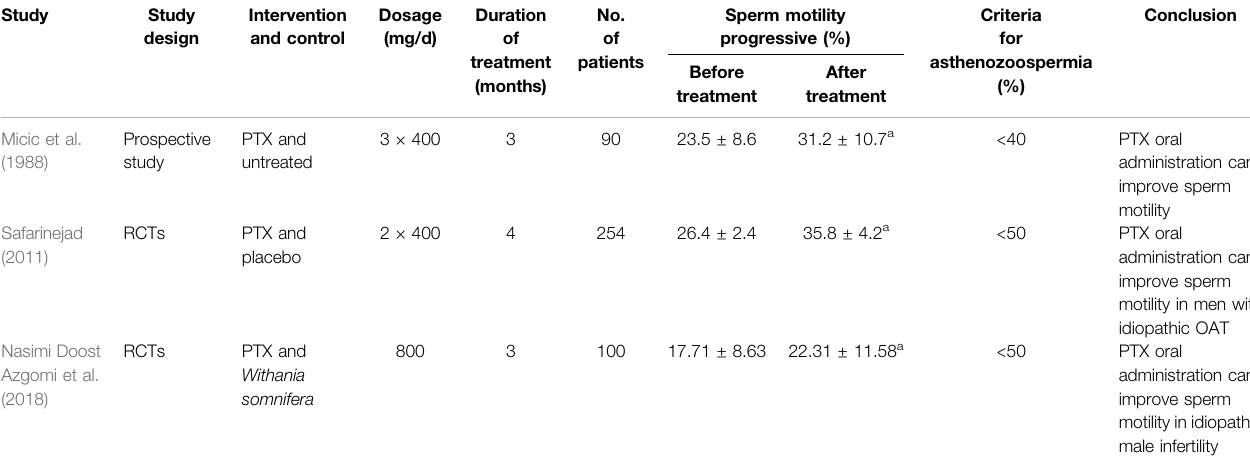
TABLE 2 | The effect of oral PTX on sperm motility.